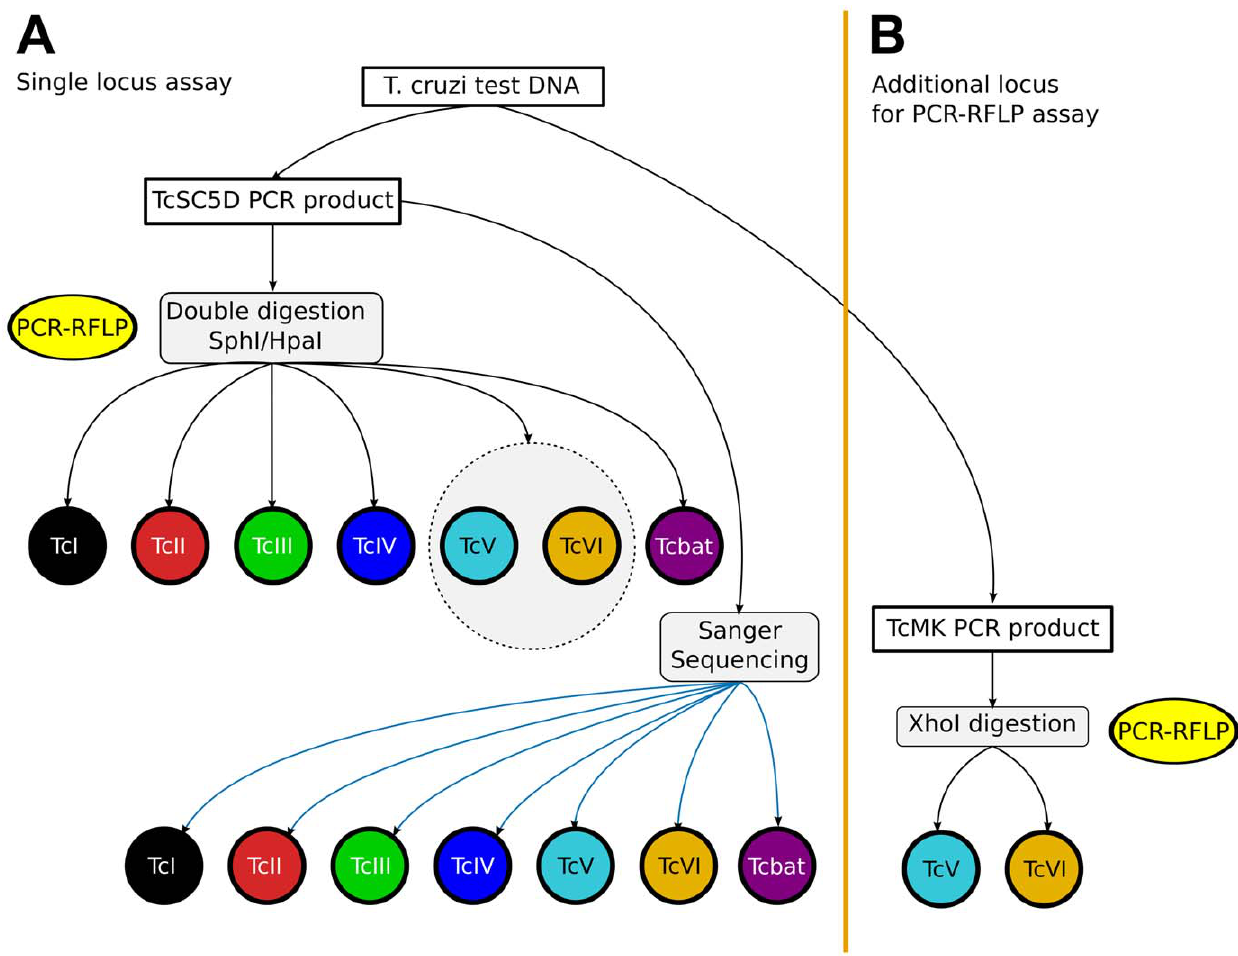
Figure 4. Proposed typing strategy based on the TcSC5D locus. A : the highly streamlined TcSC5D-PCR-RFLP assay can discriminate all non- hybrid lineages. If discrimination of DTUs TcV from TcVI is necessary, sequencing of the TcSC5D amplification locus is required. B : alternatively, if the method of choice is the PCR-RFLP, then a second locus can be assayed to resolve these DTUs. This additional locus can be the TcMK gene as shown in the figure (this work, see main text), or the gp72 gene (polymorphic Taq I site